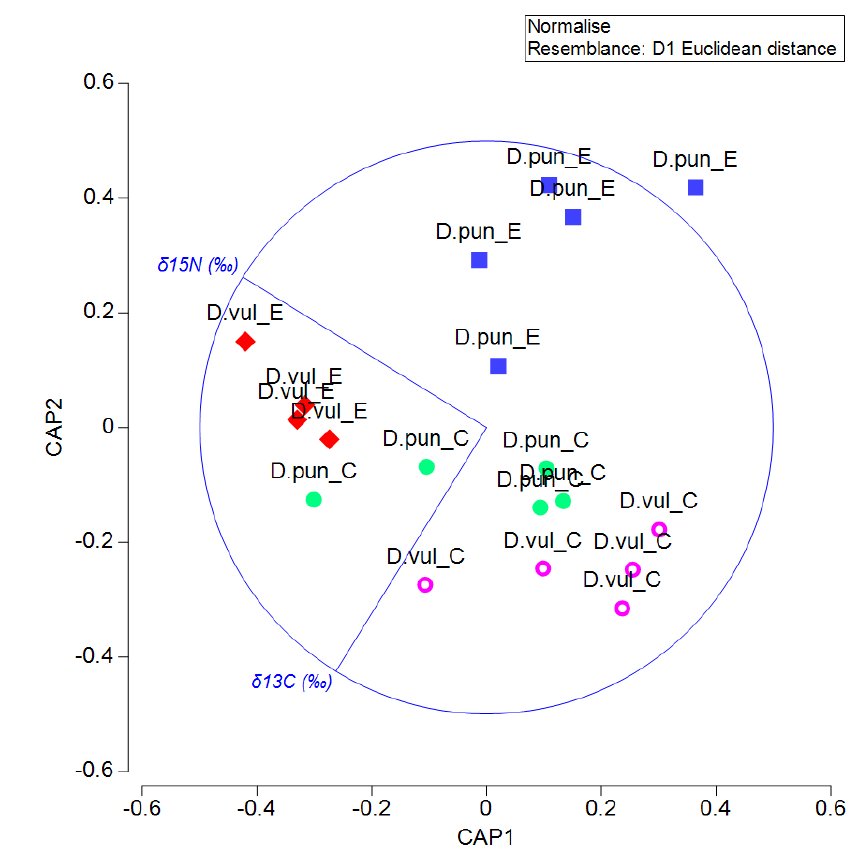
Figure 8. Canonical variate plot (CAP) of the otolith distance matrix on the isotope (continuous quantitative) values. Previously, the distance matrix based on otoliths was related to the distance matrix based on isotopes.